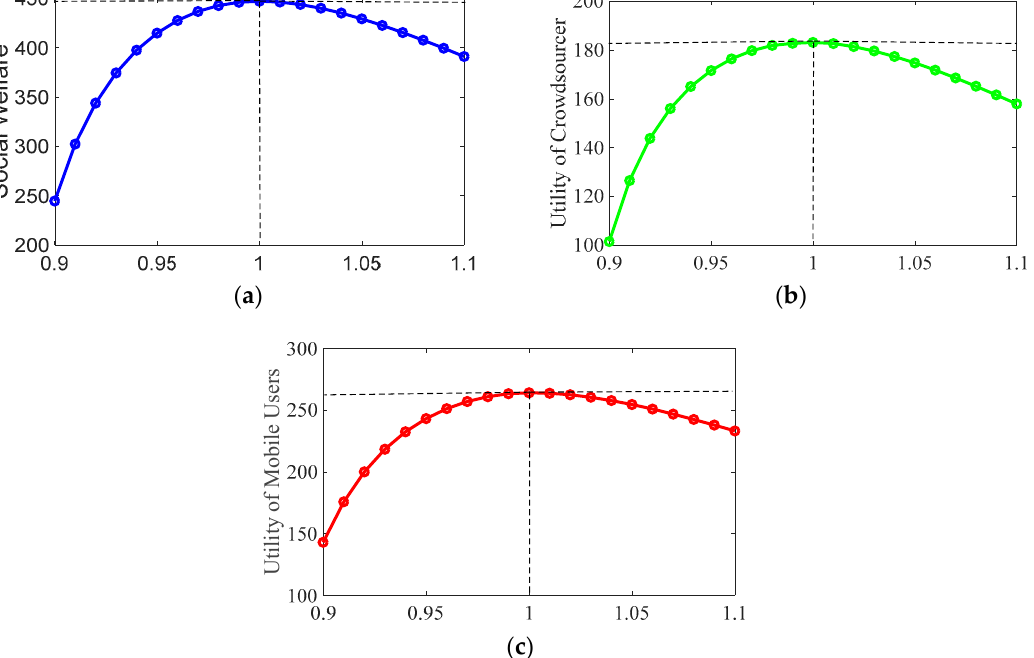
Figure 4. Performance comparison between our proposed algorithm and crowdsourcer-centric scheme: ( a ) social welfare; ( b ) utility of the crowdsourcer; and ( c ) total utility of mobile users.